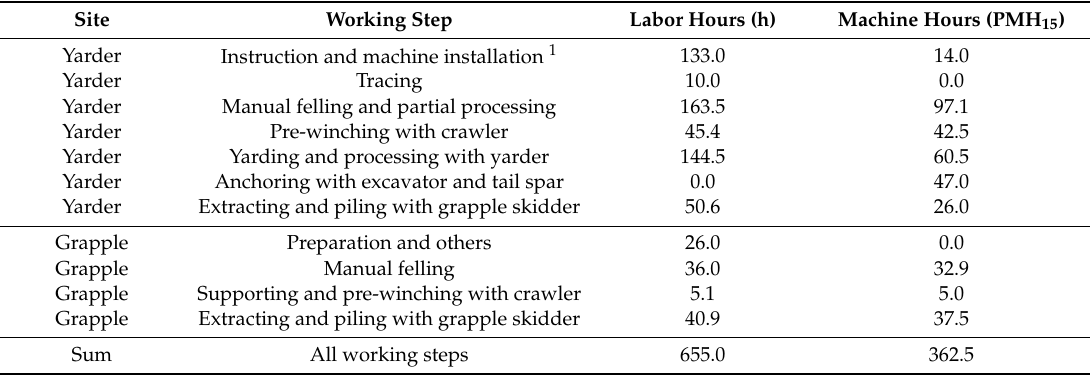
Table 4. Required labor and machines for the di ff erent working steps in the cable-based FO.